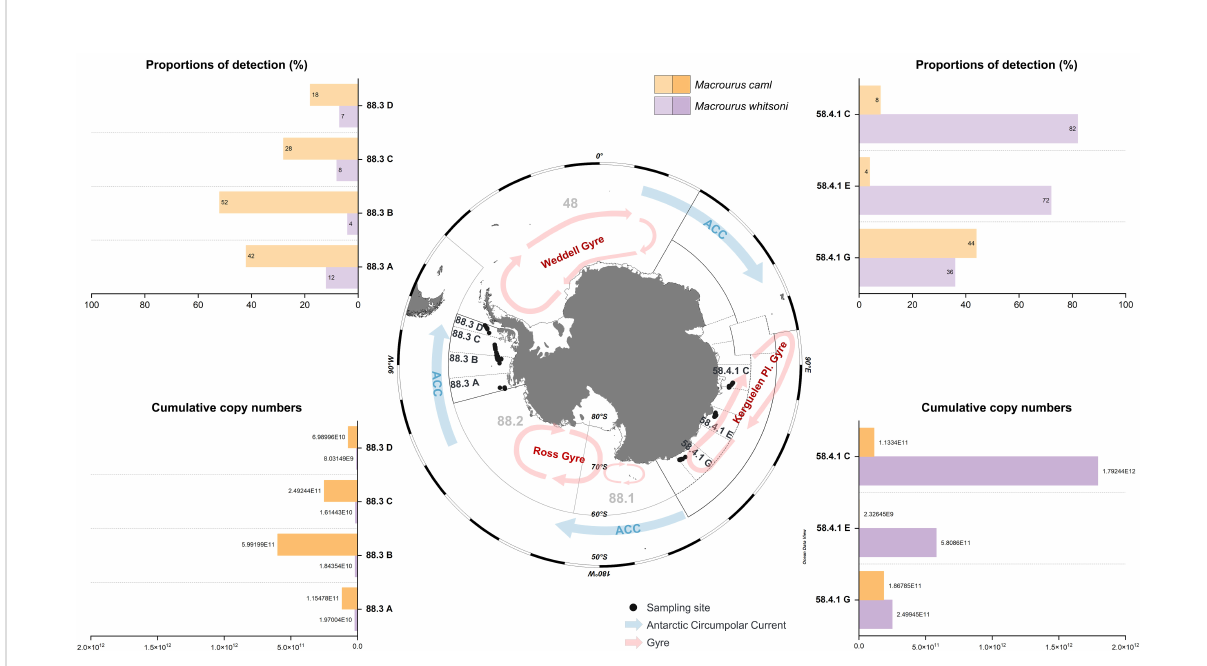
FIGURE 4 Quantitative analysis of two species of the genus Macrourus as preys of Dissostichus mawsoni. Proportions of detection (%) and cumulative copy numbers were measured using qPCR. Black dots indicate the collection sites in the small-scale research units (SSRUs) of each